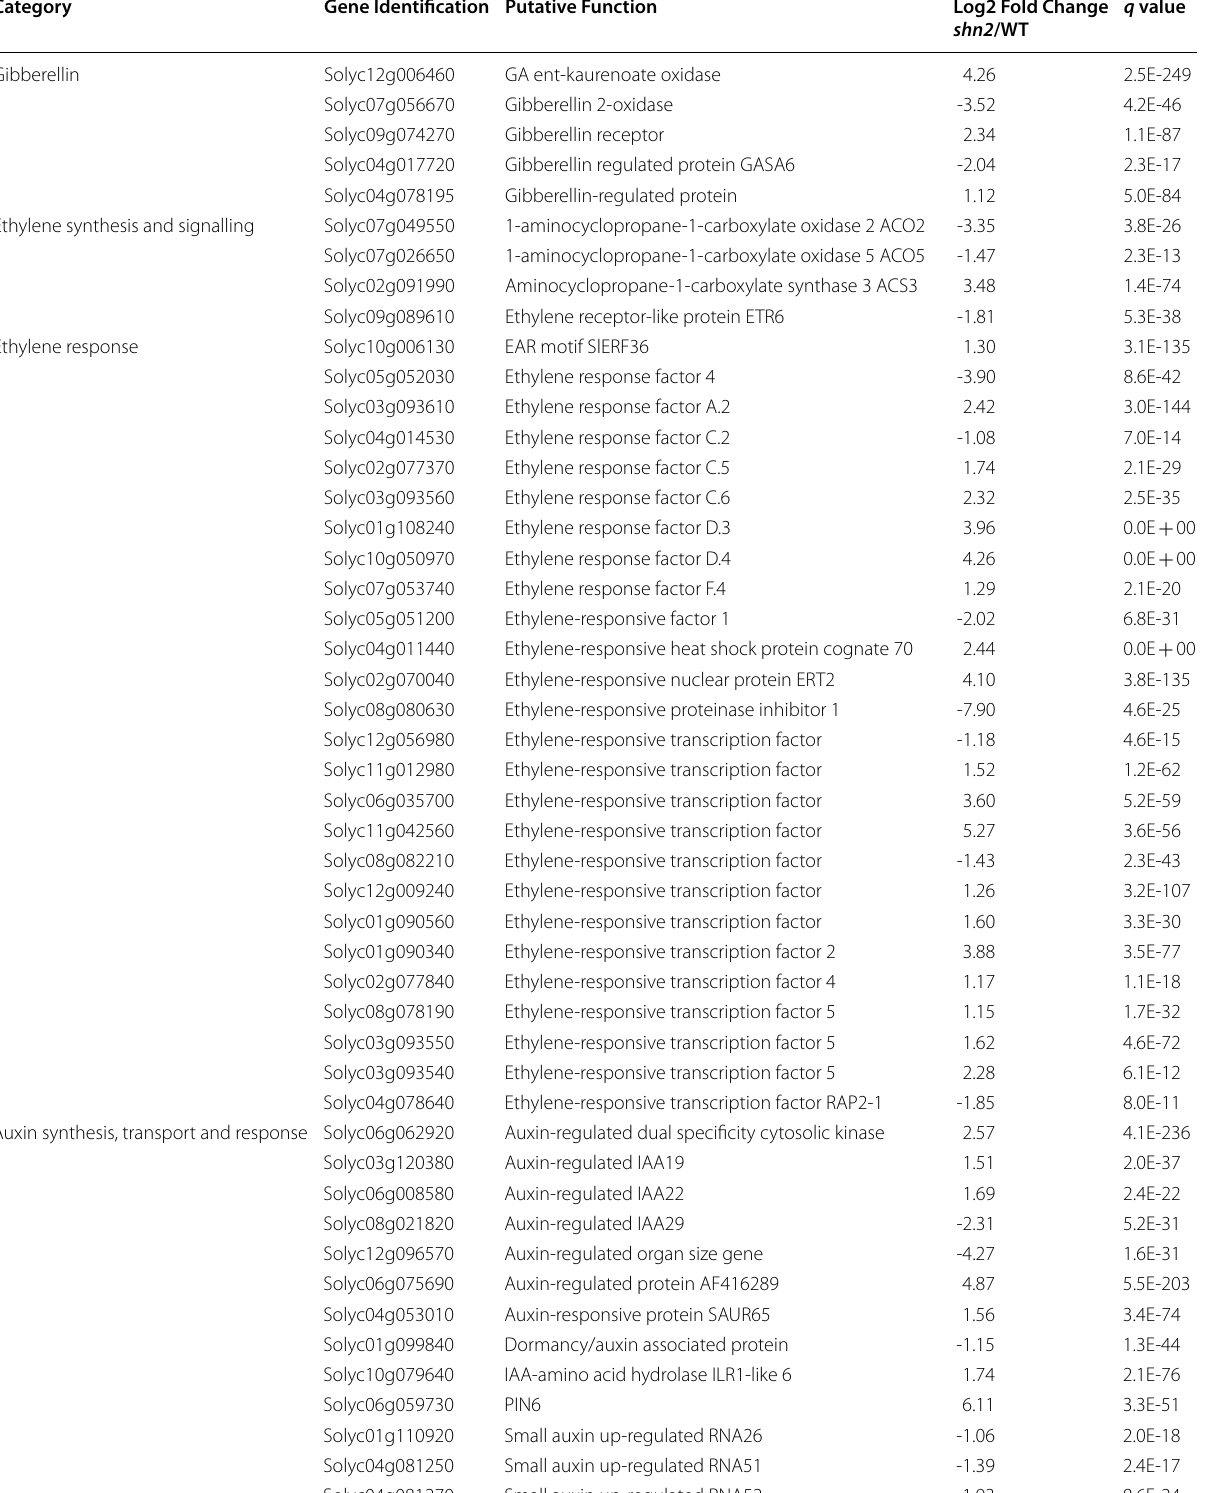
Table 2 Differentially expressed genes (DEGs) associated to hormones Category Gene Identification Putative